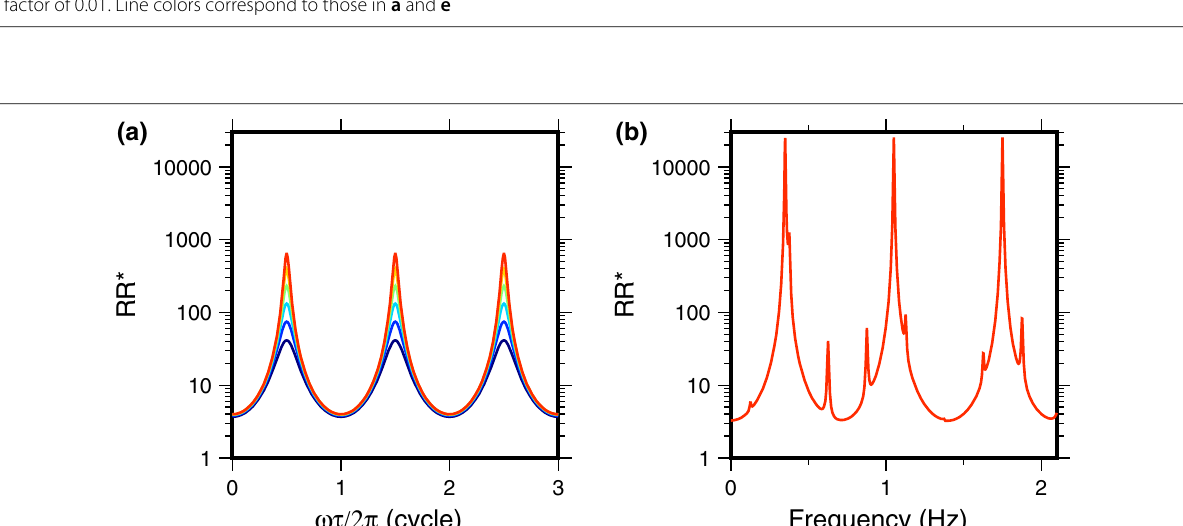
Fig. 9 Radial-component responses of a sediment layer overriding a half space. a Algebraic expression given by Equation 18 . Color notation is the same as Fig. 8a. b Numerical results. The velocity model shown by the red line in Fig. 8a is used. The incident plane S-wave has a ray parameter of 0.11 s/km and a unit